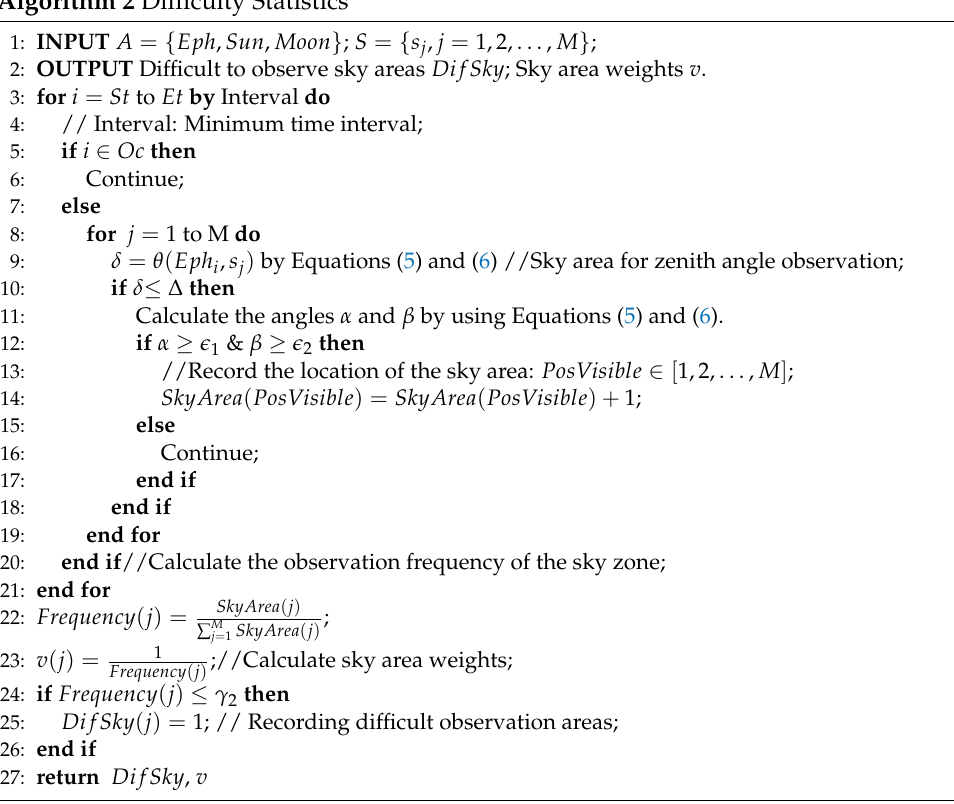
Algorithm 2 Difficulty